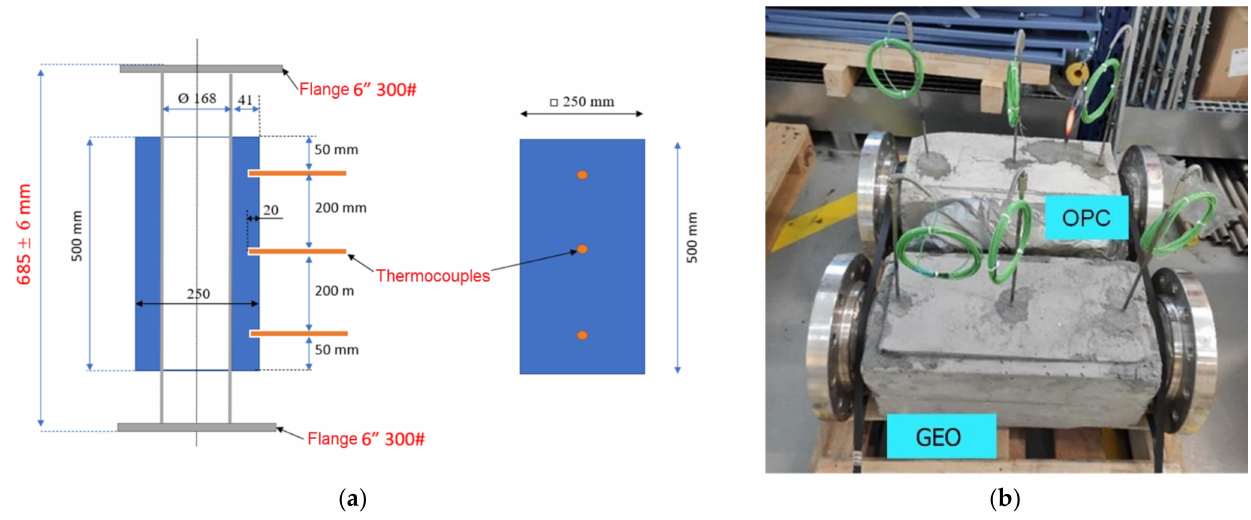
Figure 1. ( a ) Scheme and dimensions of the TES prototypes; ( b ) photograph of the concrete TES